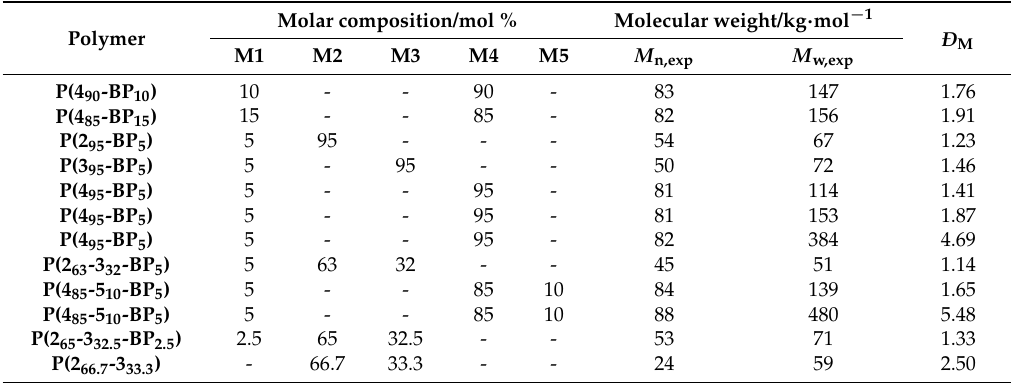
Table 1. Molar compositions, molecular weights ( M n and M w ) and polydispersity indices Ð M of the poly(alkenylnorbornenes) P(2-3-BP) and the poly(oxonorbornenes) P(4-5-BP) . M n , M w and Ð M were determined by gel permeation chromatography in chloroform using PMMA